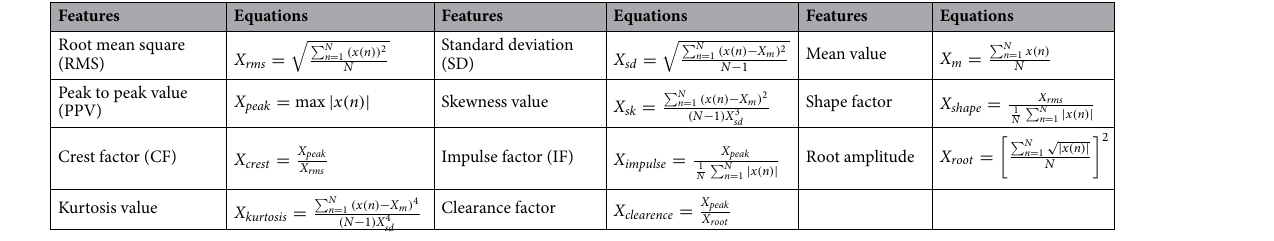
Table 2. Statistical feature based on